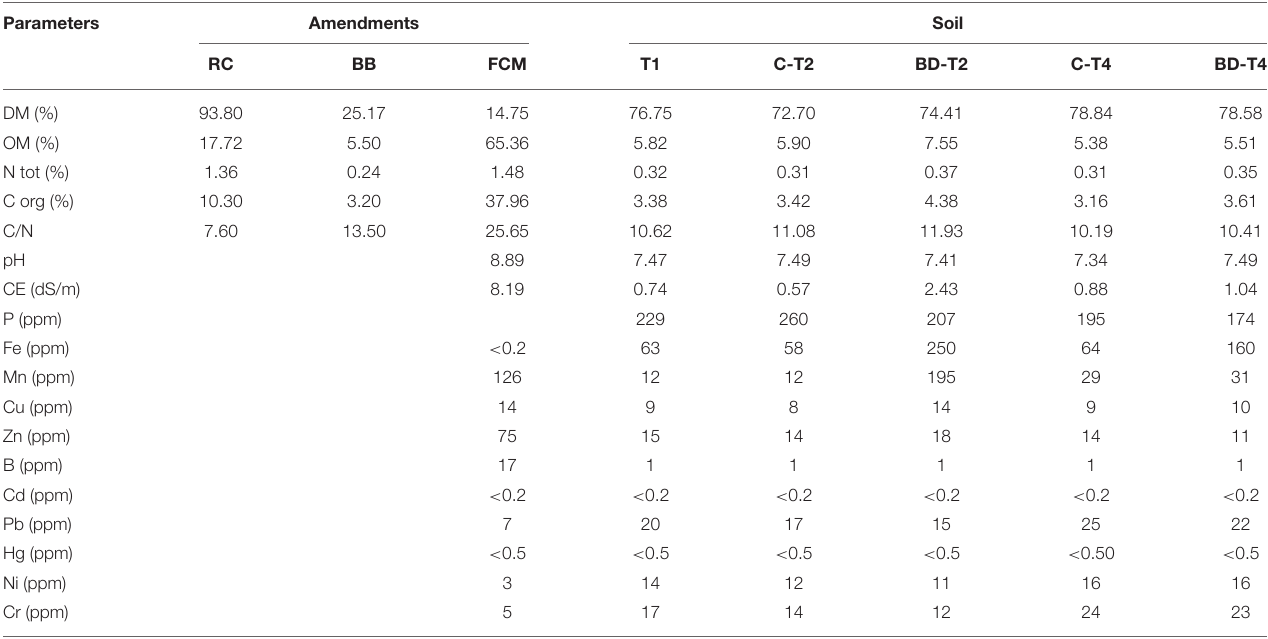
TABLE 1 | Physicochemical values [dry matter (DM), organic matter (OM), total N, organic C, C/N ratio, pH, EC, some available nutrients and presence of heavy metals] of the amendments used for the biodisinfestation treatment: RC (rapeseed cake); BB (beer bagasse); FCM (fresh cow manure).